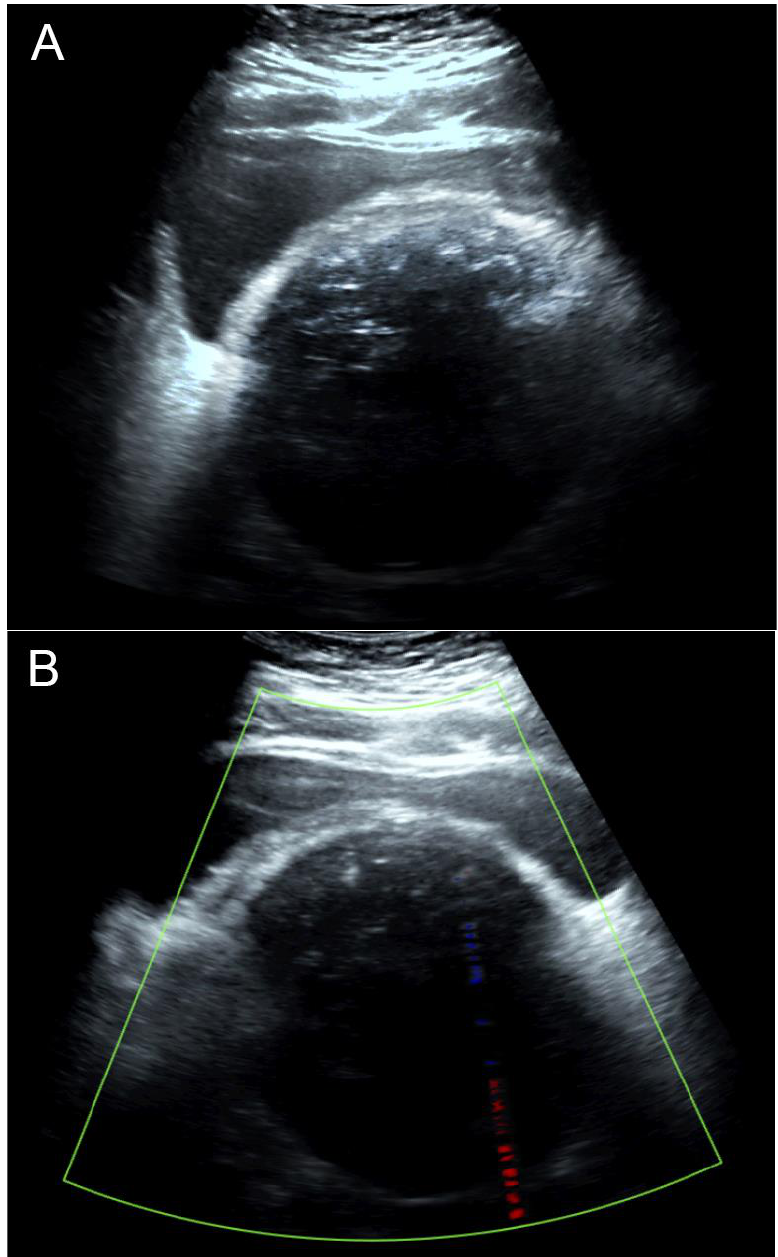
Figure 2. Transabdominal ultrasound images: ( A ) The 2D ultrasound showed a pelvic mass of uncertain anatomical origin, with severe acoustic shadow, obscuring all details behind the calcifications on the surface of the mass. ( B ) Color flow mapping showed no vascularization. Note that there were no multiple-edge shadows typical for uterine leiomyomas because multiple calcifications completely obscured all of the structures underneath the surface facing the ultrasound beam. The ultrasound beam cannot pass through several layers of calcific discrete pellets. Accordingly, the popcorn appearance cannot be produced by ultrasound, and the examination should be considered suboptimal and non-informative. Though uterine leiomyomas can sonographically be diagnosed with confidence in most cases, severely calcified leiomyomas can be a diagnostic challenge because of suboptimal and non-informative examinations.